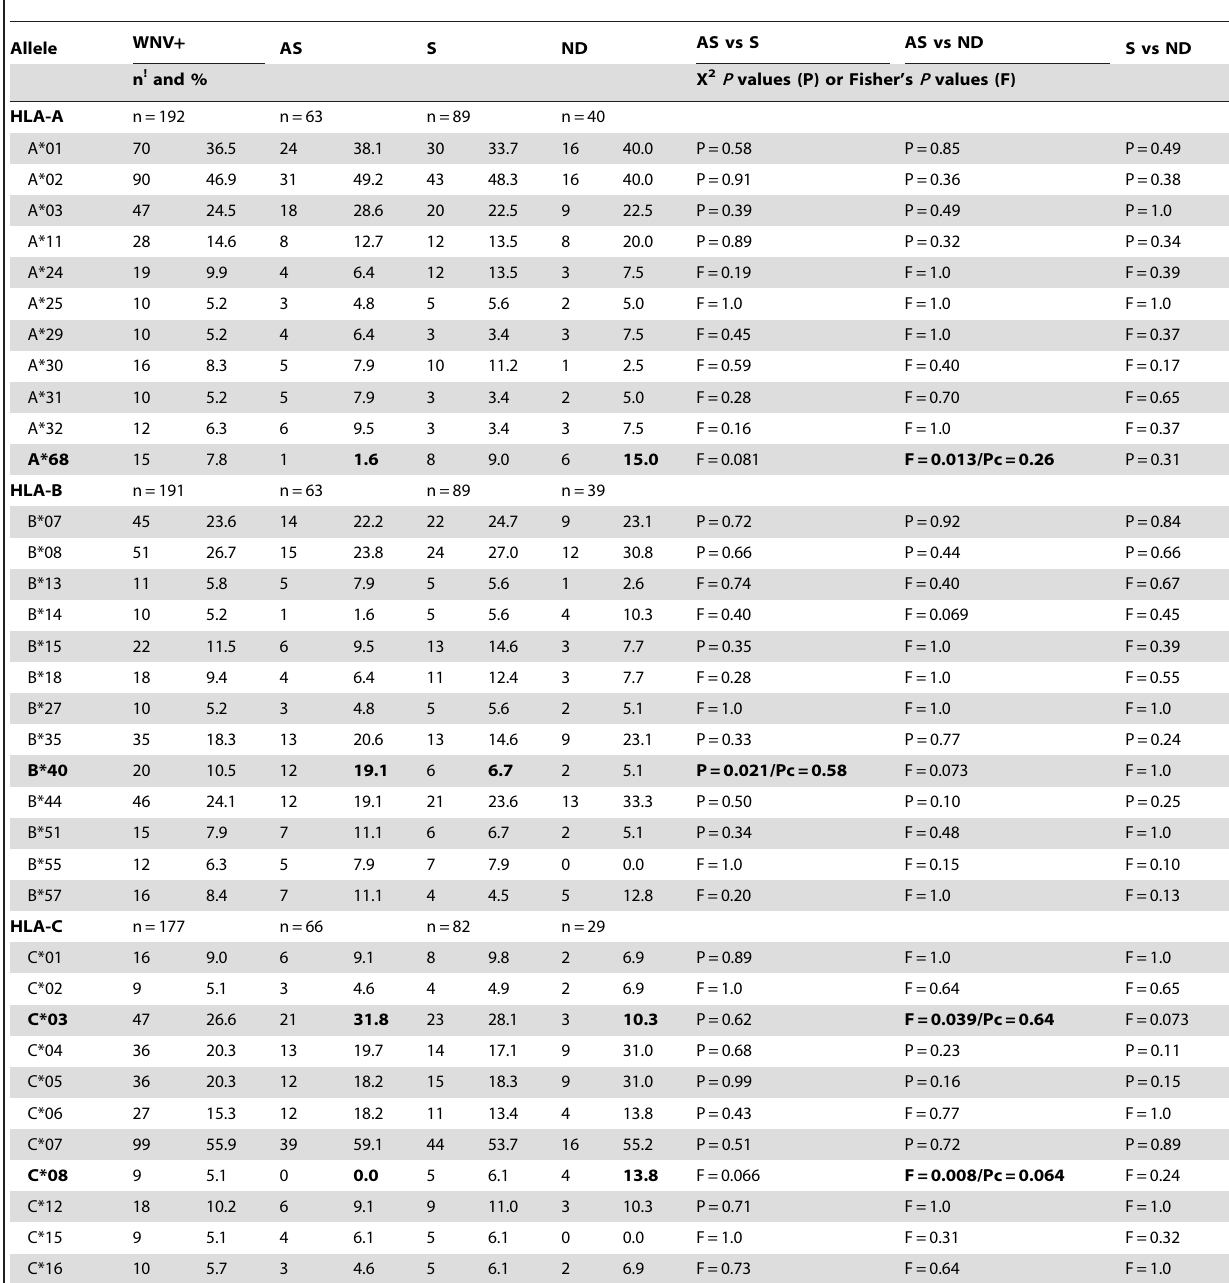
Table 2. Pair-wise analysis of HLA Class I phenotype frequencies* in asymptomatic (AS), symptomatic (S), and neuroinvasive disease (ND) groups of WNV +